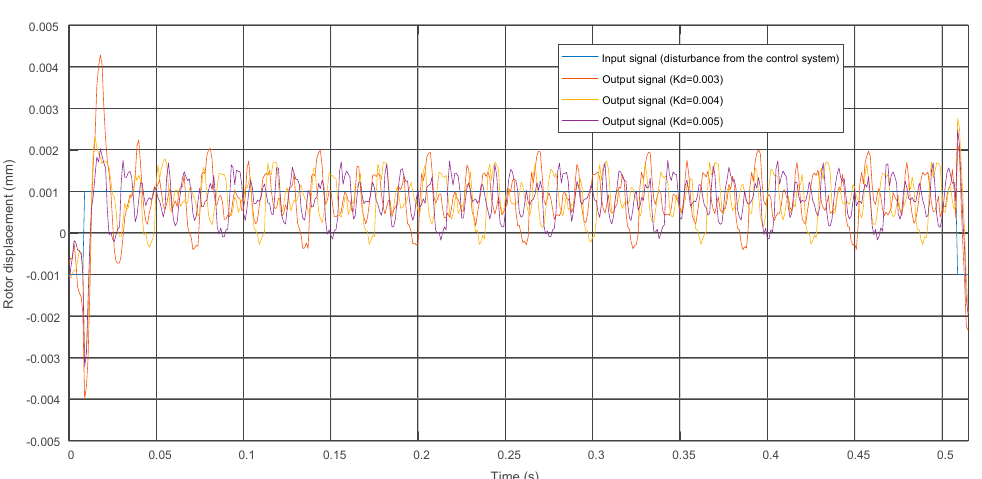
Figure 6. Time characteristics of the control systems with proportional-derivative PD controller for different K d values and constant K p equal to 1.75.